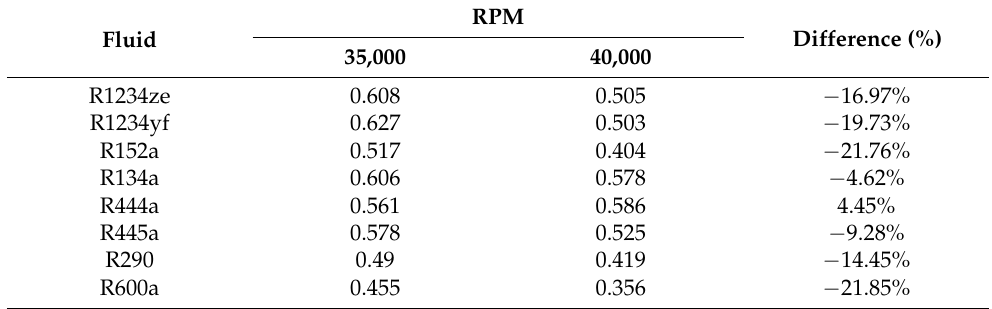
Table 5. Pressure Ratio Increase Per Specific Work Done by the Compressor Based on 1 kg of Fluid.